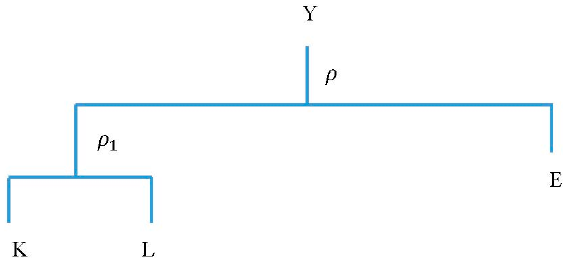
Figure 4. KL(E) nesting for the CES function, adapted from Lecca et al. [44].